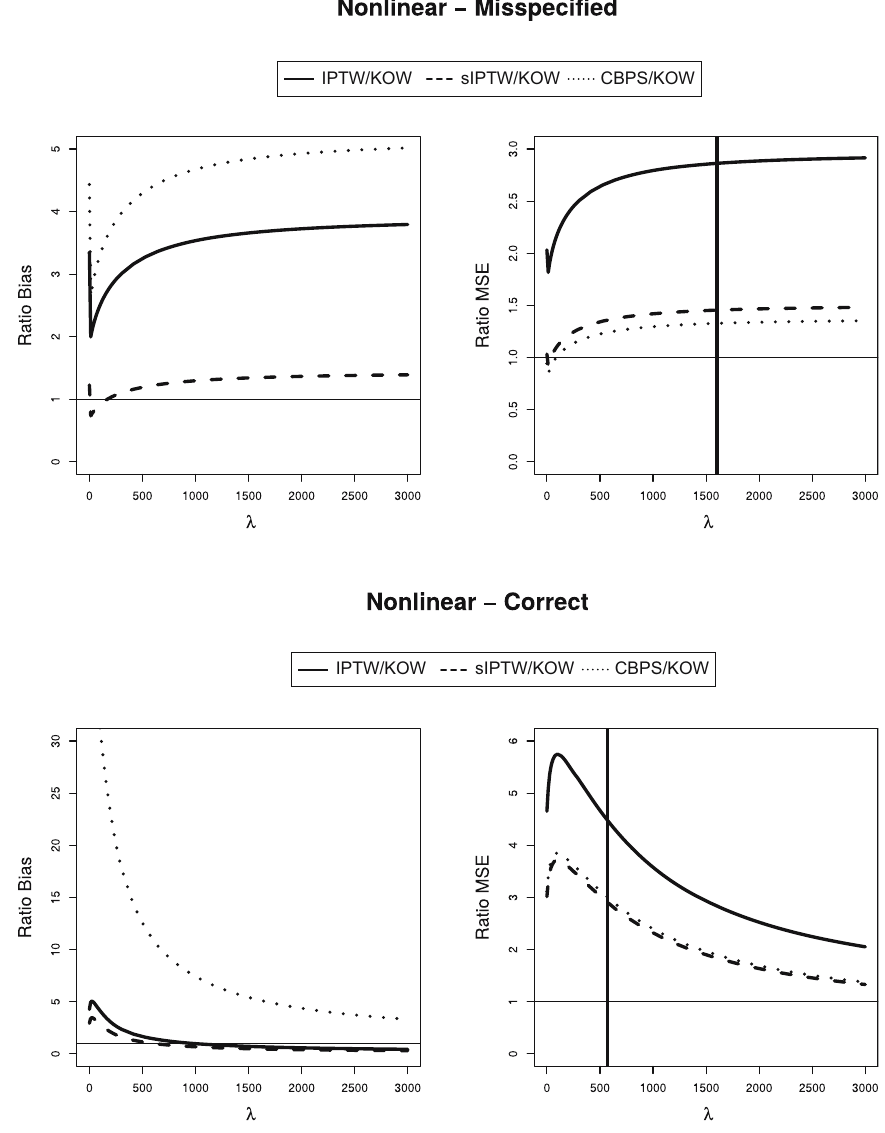
Figure 5: Ratios of squared biases and MSEs comparing KOW with IPTW ( solid ) , sIPTW ( dashed ) , and CBPS ( dotted ) across values of λ 0,…, 3,000 = in the nonlinear - misspeci fi ed scenario ( top panels ) and in the nonlinear - correct scenario ( bottom panels ) . Ratios above 1 means that KOW had a lower bias or MSE. Vertical bars show the mean value of λ 0,…, 3,000 = , across simulations, obtained as described in Section